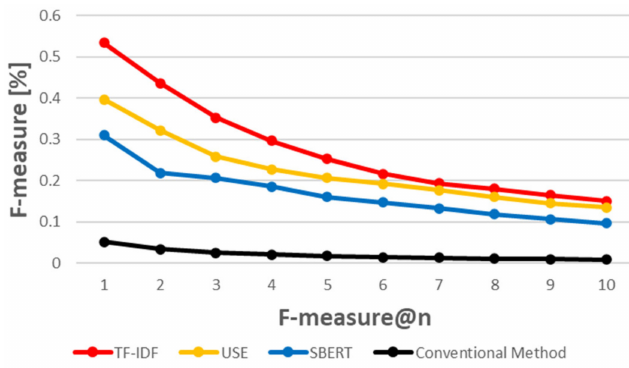
Figure 11. F-measure for each